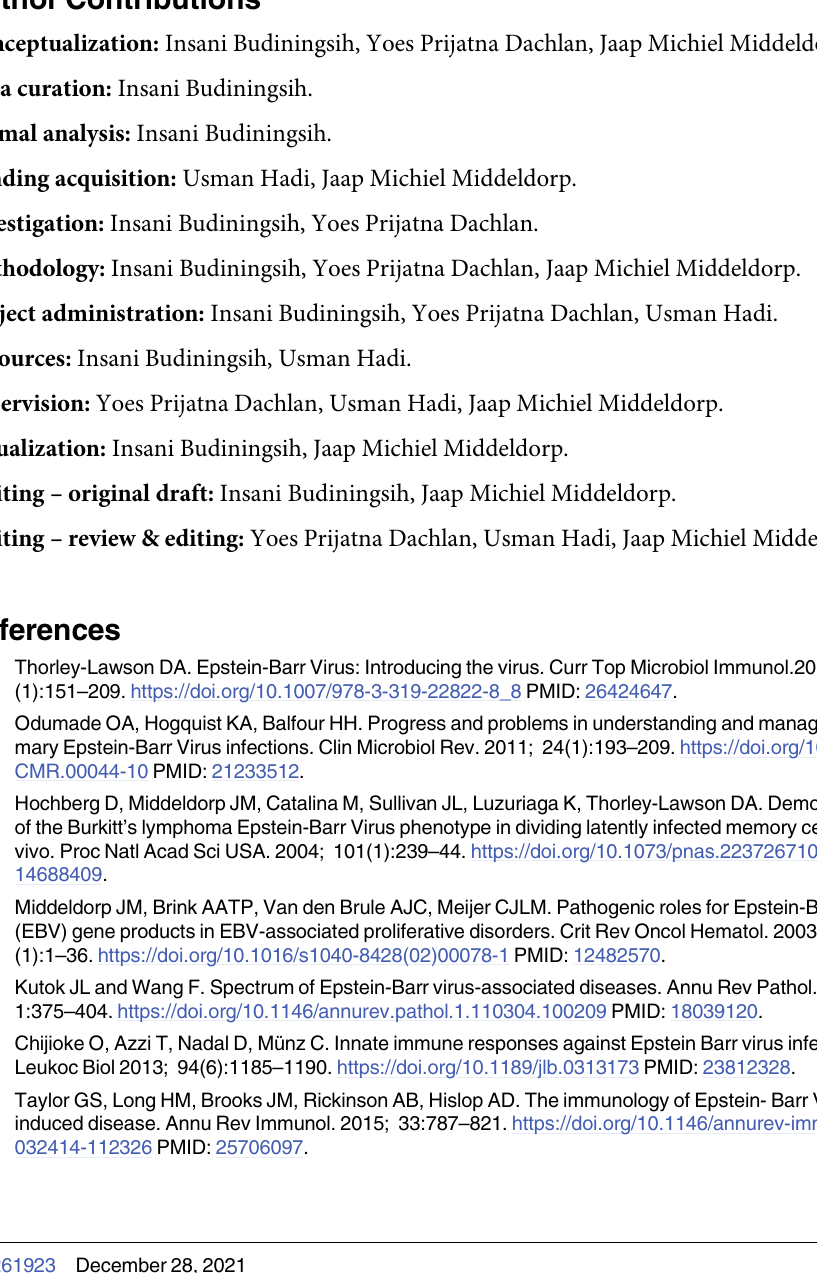
S4 Fig. Comparison of EBV-DNA load and levels of 4 cytokines versus age in male and female cases of Malaria due to infection with P . falciparum , P . vivax or both. Statistical analysis was done by linear